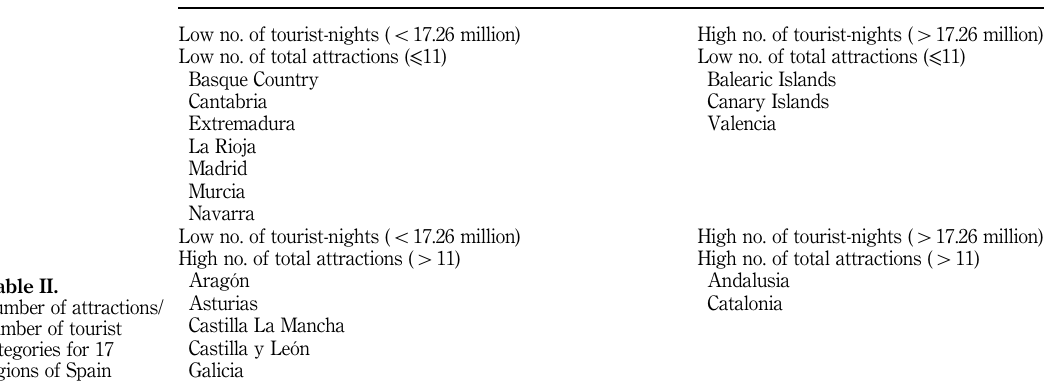
Table II. Number of attractions/ number of tourist categories for